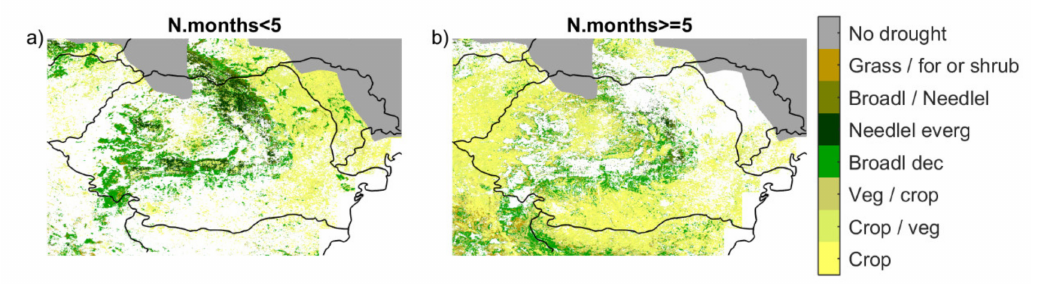
Figure 7. Land cover classes associated with NDVI anomalies below − 0.025, over ( a ) less than 5 months and ( b ) 5 months or longer. Areas where drought duration was 1 or 2 months, as assessed by SPEI 6, are shown in